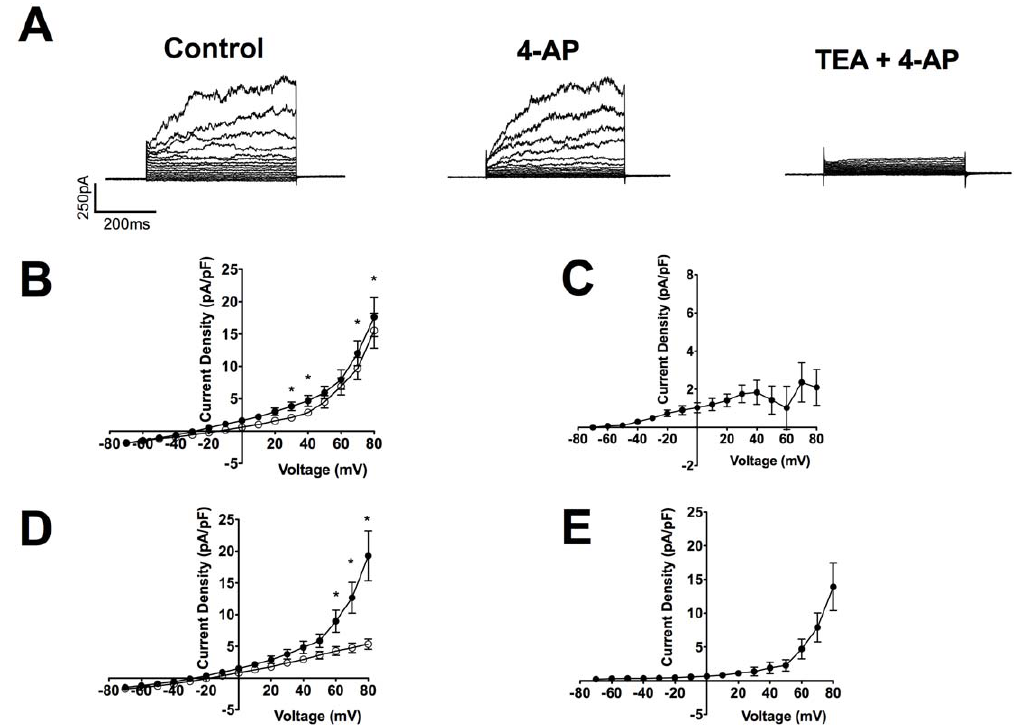
Figure 3. Characterisation of functional voltage-gated (K v ) and Ca 2 + -activated K + channels (K Ca ) in CPASMCs. Representative example of the inhibition of outward currents in CPASMCs at negative membrane potentials by the K v blocker 4-aminopyridine (4-AP; 5 mM; A ) and at depolarised potentials following co-application of the K Ca inhibitor tetraethylammonium (TEA; 5 mM; A ). Mean current-voltage relationships measured at the end of the 500 ms voltage step ranging from 2 70 mV to + 80 mV were obtained in the absence ( n=11, N=8) and TEA alone ( D ; n=11, N=6). * indicates currents (mean 6 SEM) P , 0.05; Two-way ANOVA followed by Bonferroni Post Hoc Test. 4-AP ( C ) and TEA ( E ) sensitive currents were linear and outwardly rectifying